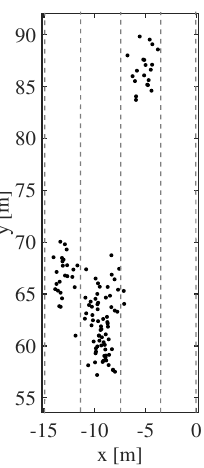
Figure 11. Sampling points of Scene